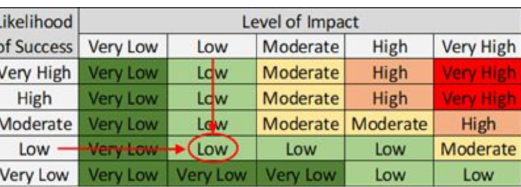
Figure 7. Adjusted Risk Determination.